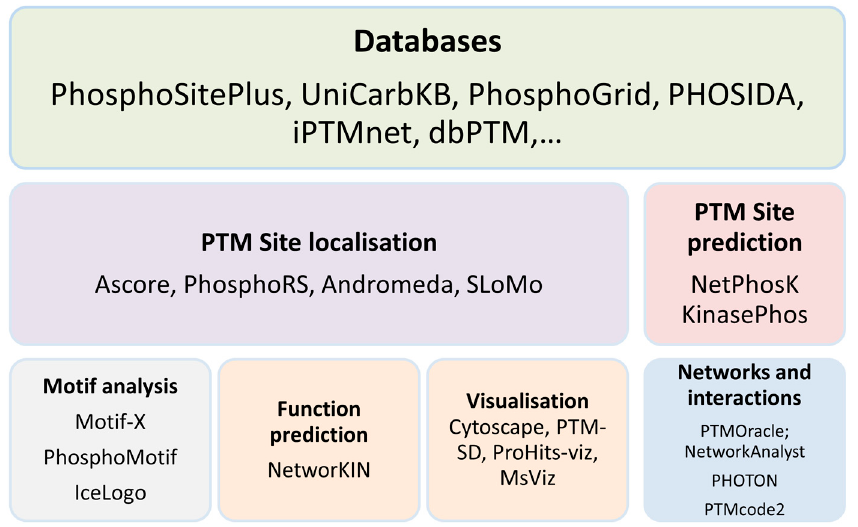
Figure 3. PTM tool categories, and a few highlighted examples.